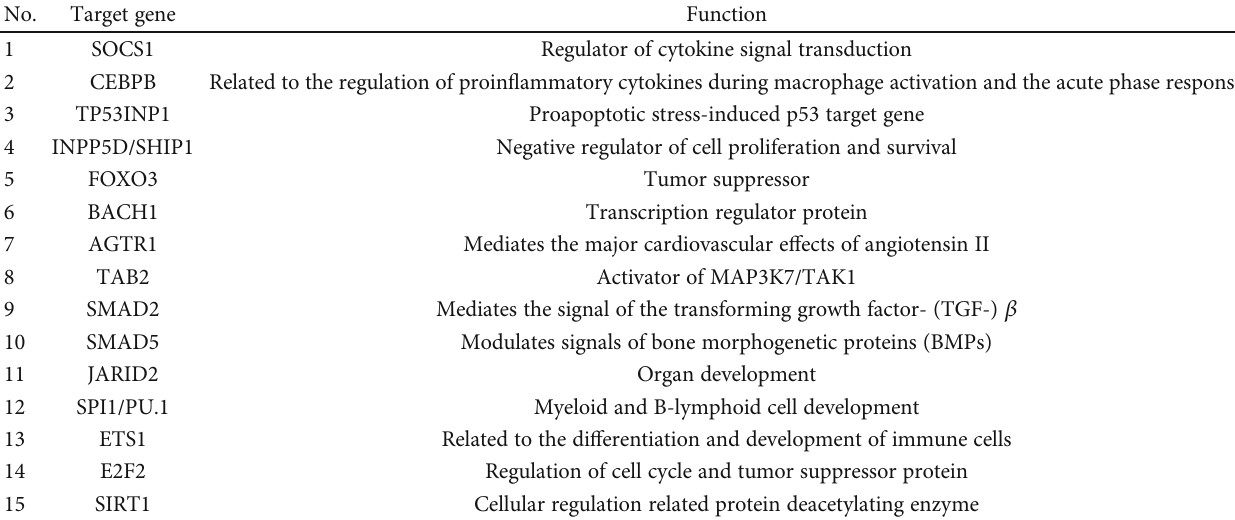
Table 1: Targeted genes of miR-155 that have been experimentally con fi rmed.